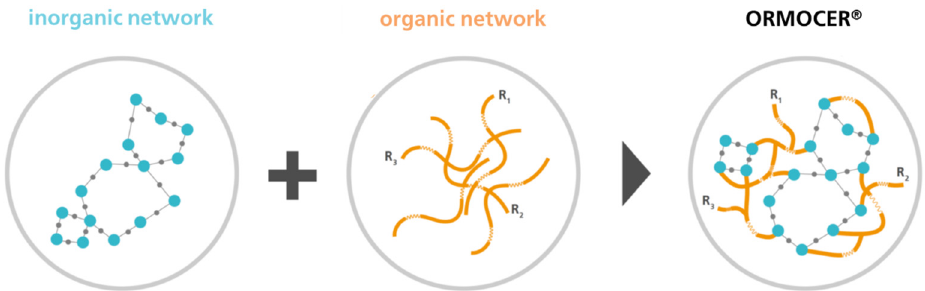
Figure 1. Hybrid polymers (ORMOCER ® developed by Fraunhofer ISC, trademark of Fraunhofer Gesellschaft zur Förderung der angewandten Forschung e.V., München) [Fraunhofer ISC]. ORMOCER ® -based coatings are hybrid polymers that can be synthesized by the sol– gel technique. If extremely low permeation values are needed, the combination of hybrid polymer coatings with thin inorganic layers (SiO x , AlO x ) is very effective and leads to permeation values for oxygen and water vapor below 10 − 3 cm 3 /(m 2 d bar) or g/(m 2 d), 85% r.h. to 0% r.h. at 23 °C [16]. These passive barrier layers can be further improved by